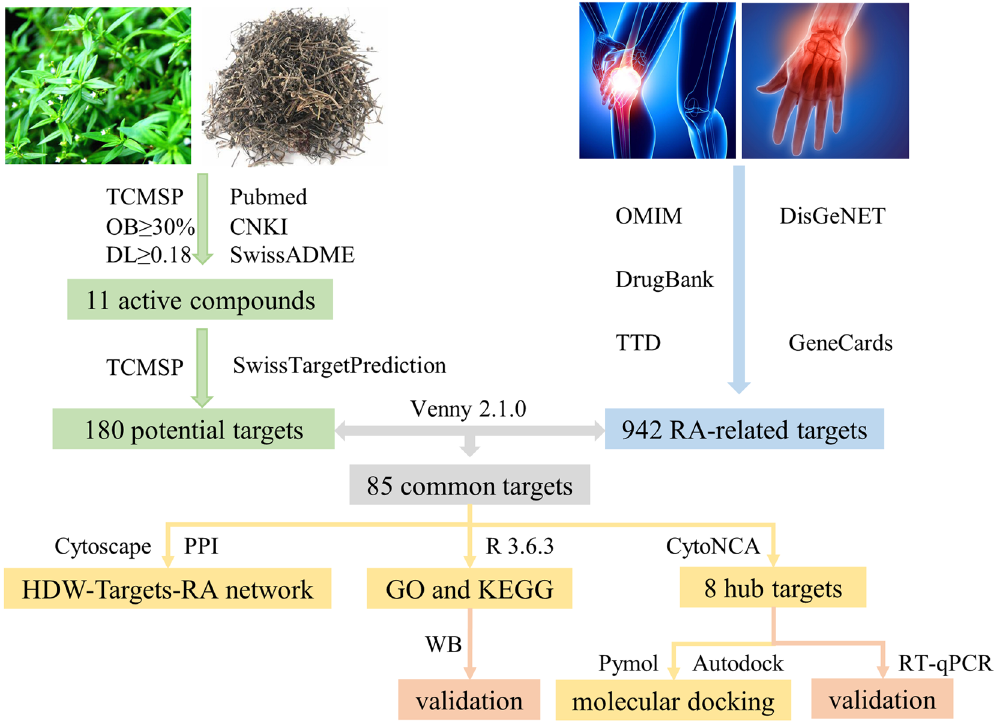
Figure 1. A flow-chart of this study to investigate the potential mechanism of HDW in treatment of